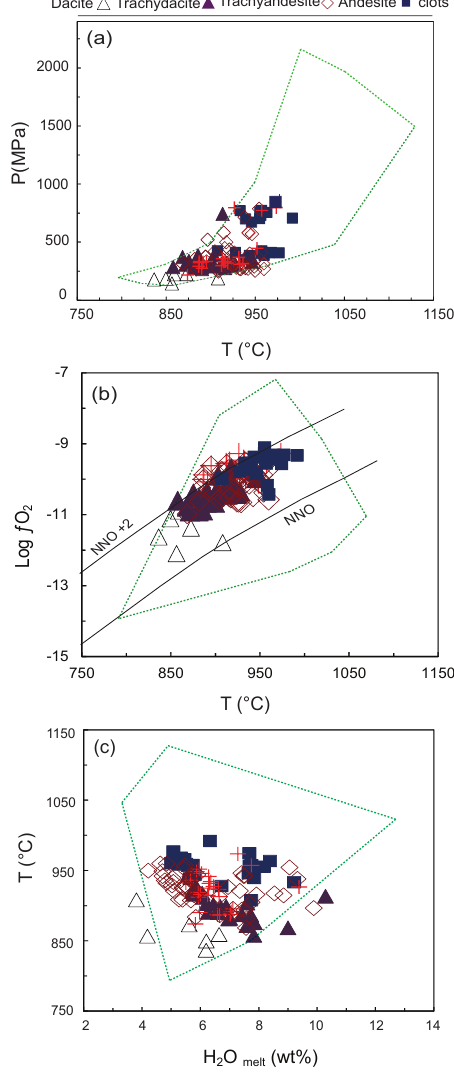
Figure 13. (a) P – T diagram for calcic experimental amphiboles af- ter Ridolfi and Renzulli (2012) with low uncertainties ( T ± 23.5 ◦ C, P ± 11.5%). Our amphiboles plot in the field of experimentally reproduced amphiboles (after Ridolfi and Renzulli 2012). (b) Log ( f O 2 )- T and (c) T –H 2 O melt diagrams for the studied amphiboles as obtained by amphibole thermobarometry after Ridolfi and Ren- zulli (2012). This method indicates typical uncertainties for log f O 2 errors ( ± 0.2 log unit) and H 2 O melt ( ± 0.8wt%). The NNO and NNO + 2 curves are from O’Neill and Pownceby